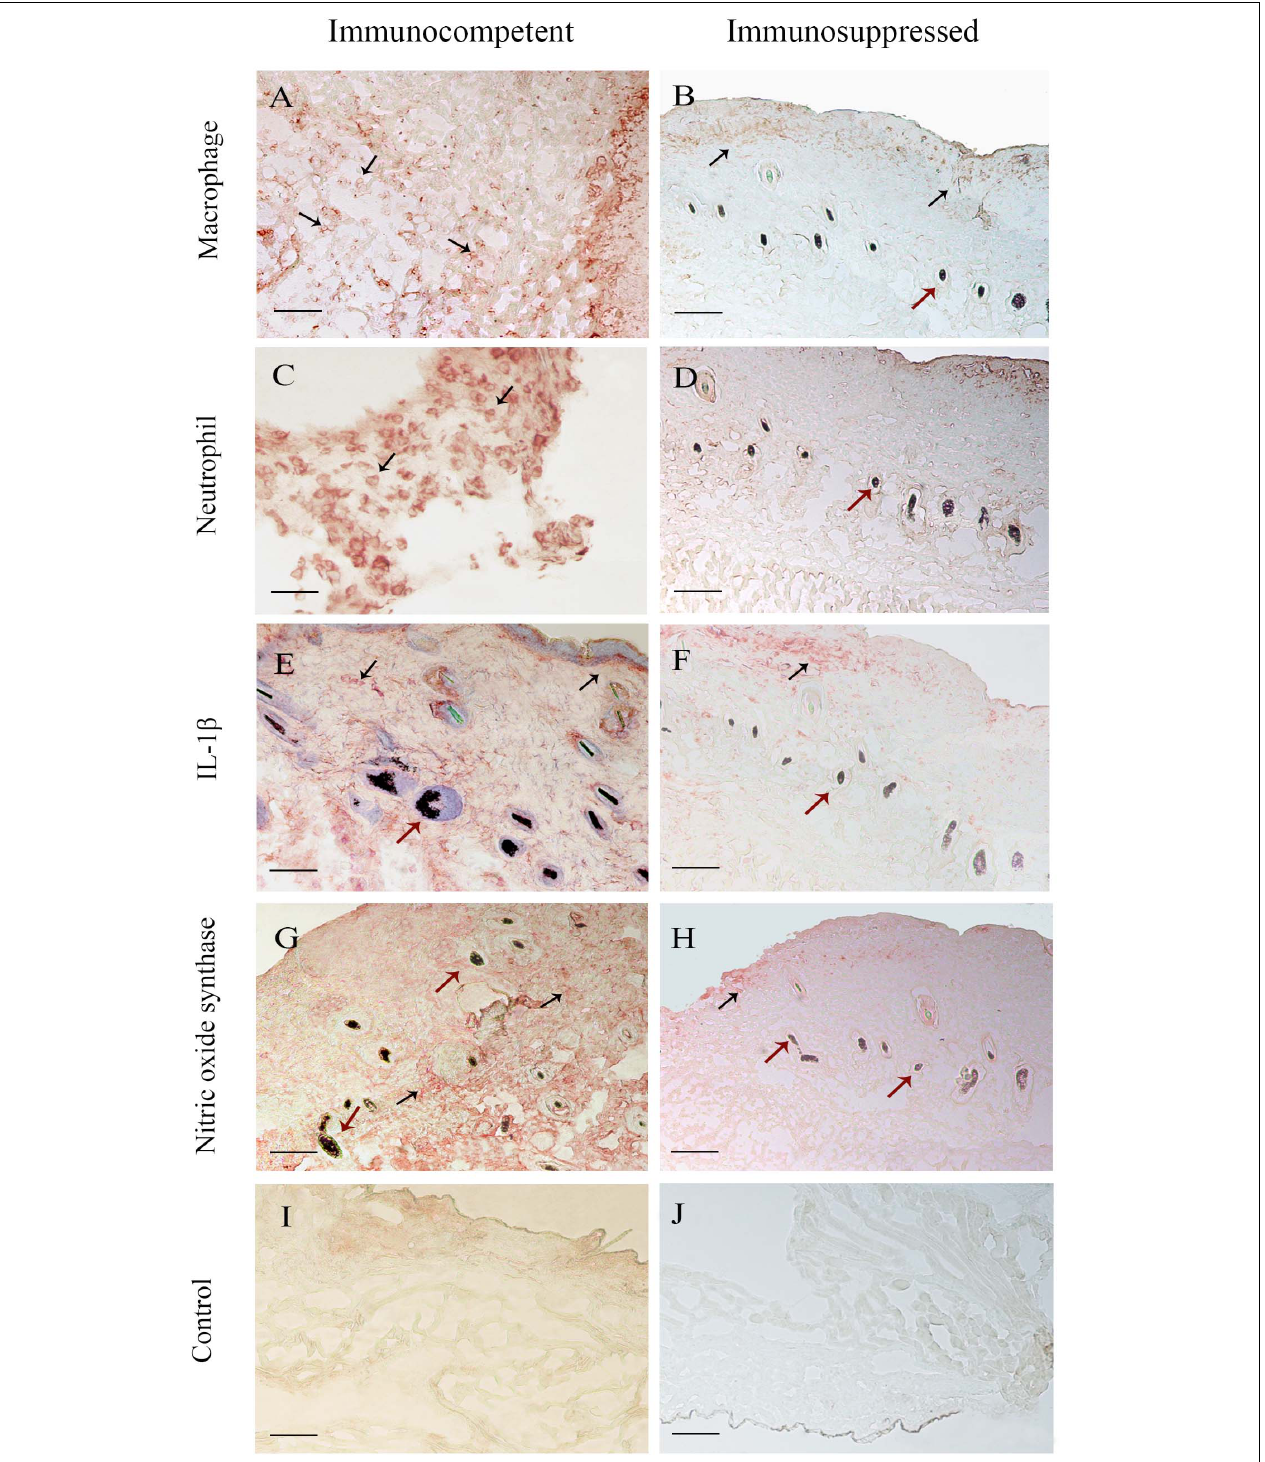
FIGURE 4 | Immunohistochemical analysis of skin biopsy of immunocompetent (left column) and immunosuppressed (right column) mice 7 days after infection. Mice were inoculated at the tail base with 1 × 10 5 conidia of Purpureocillium lilacinum and control groups were inoculated with phosphate-buffered saline (PBS). The black arrows show the frequencies of (A,B) macrophages and (C,D) neutrophils and the intensity of interleukin (IL)-1 β (E,F) and nitric oxide synthase (G,H) production. (I,J) Control group. The red arrows signal the hair follicle of mice tail epidermis (— = 100 µ m).